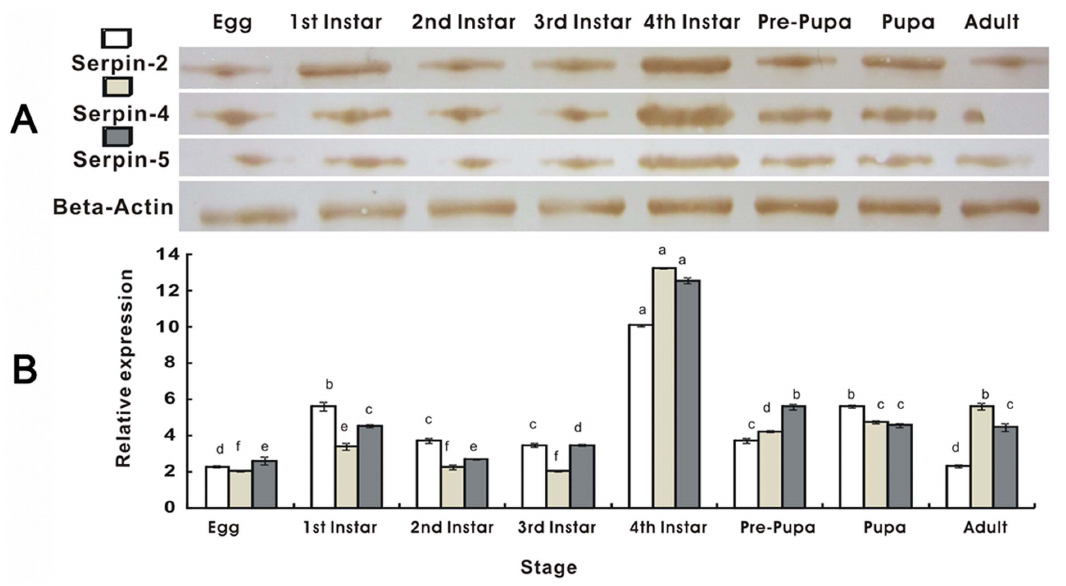
Figure 5. Expression of serpin-2, serpin-4 and serpin-5 in different lifestages of Plutellaxylostella detected by Western Blot (A) and qRT-PCR (B). The mRNA and protein levels were normalized relative to the b -Actin. The different letters above the columns indicate significant differences in serpin gene expression during P. xylostella development ( P , 0.05). Each point represents mean value 6 S.E.M of three independent experiments with three individuals in each replicate. Western Blot analysis visualized by